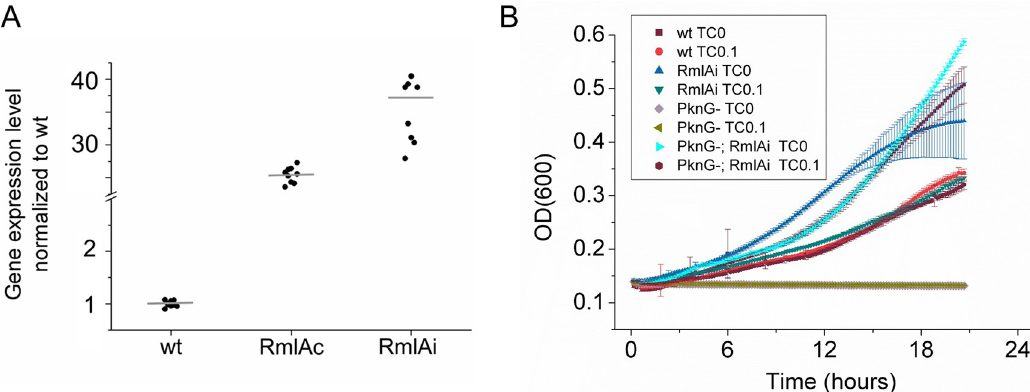
Fig 2. RmlA overexpression in M . smegmatis and its effect on cell growth. A) Overexpression was evaluated by measuring mRNA levels of RmlA in WT and overexpressing strains (RmlAi–induced overexpression by the addition of 0.05 μ g /ml TC, or RmlAc—constitutive overexpression). RmlA levels in RmlAc and RmlAi strains were 25 and 40 fold higher (p < 0.008) than in the WT M . smegmatis , respectively. B) WT, RmlAi, PknG(-), and PknG(-); RmlAi M . smegmatis strains were grown in liquid culture without any treatment or with 0.1 μ g/ml TC. OD (600) was measured every 10 min in a plate reader.